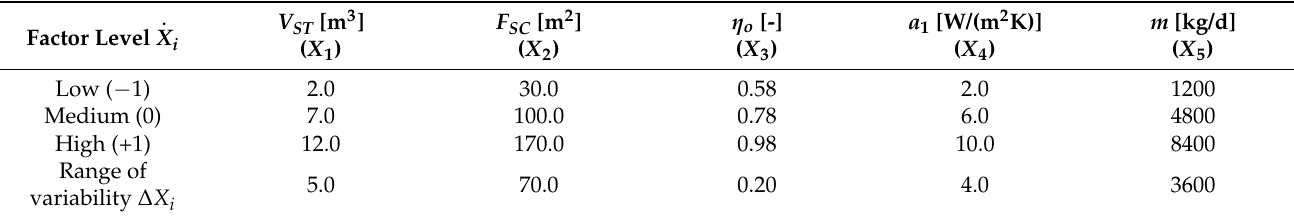
Table 4. Natural and standardized values of the factors.